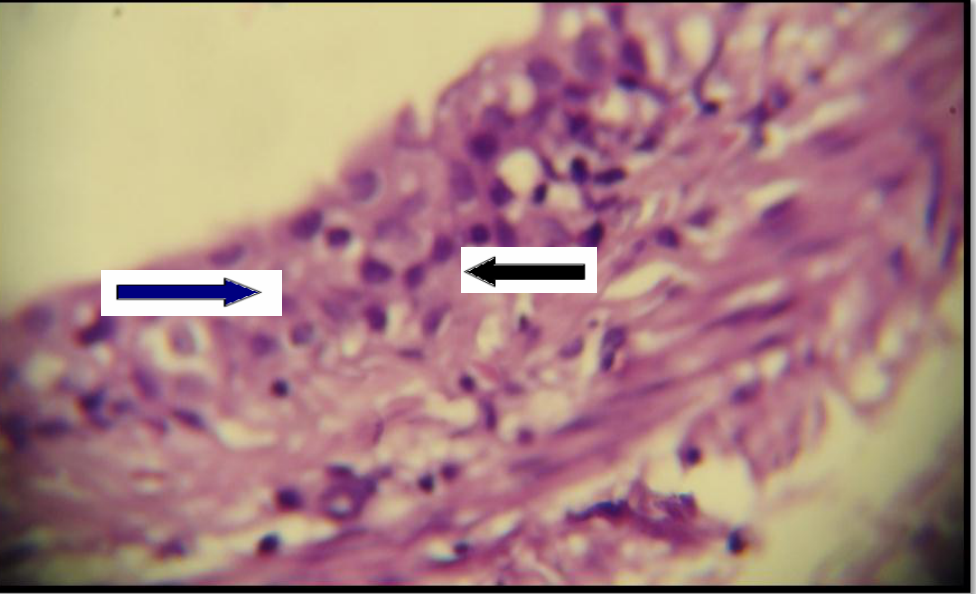
Figure (6) : Histological section in kideny in animal infected with S. saprophyticus at 14 days and treatment with alcoholic extract Plantago lanceolata showed hyperplasia of mucosal